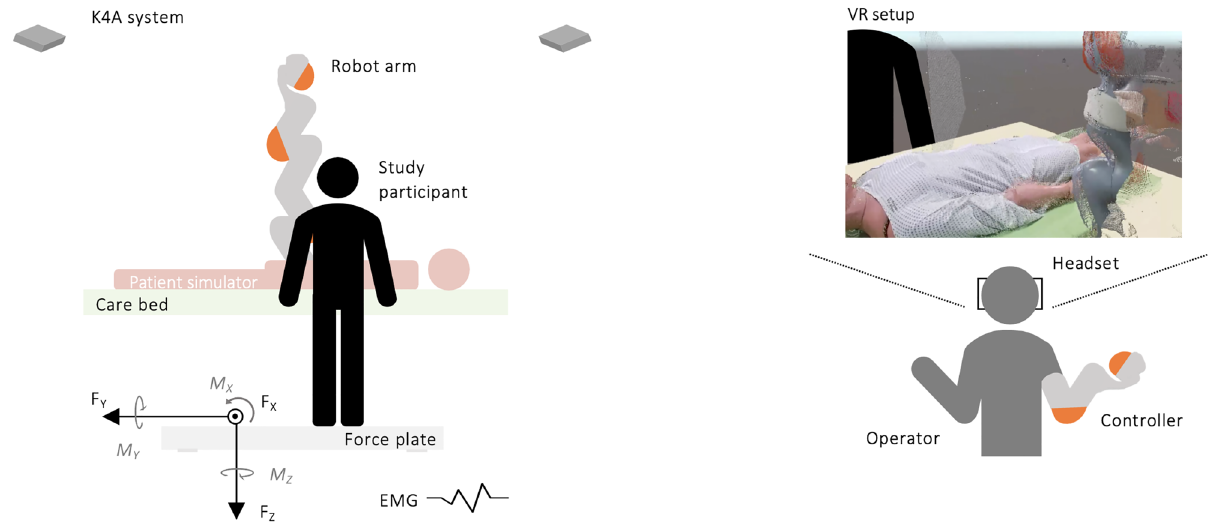
Figure 1. Schematic representation of the study setup of the collaborative robotic system from the side view, including an illustration of the operator’s VR interface (right) to control the robot arm attached to the care